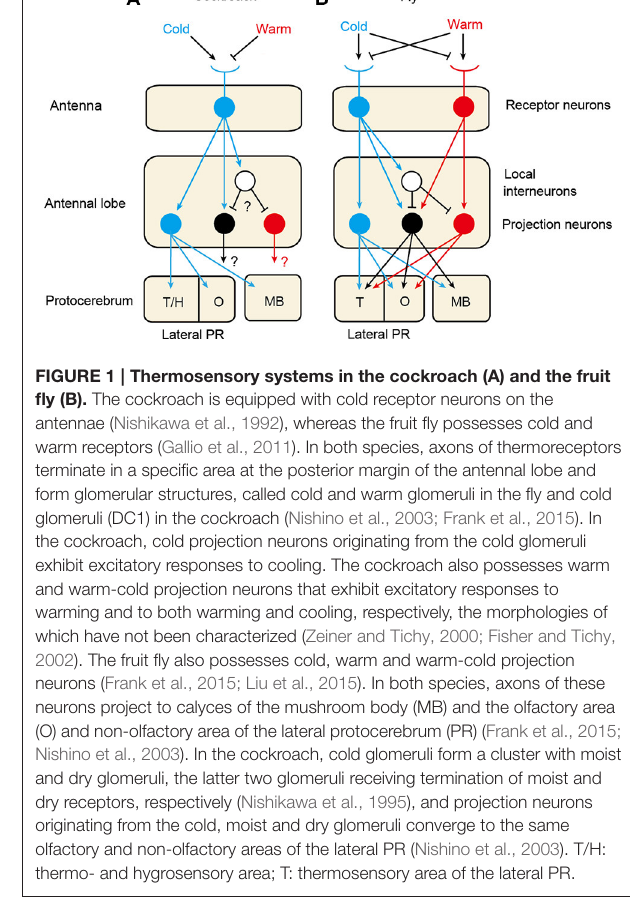
for survival of small animals such as insects (Yokohari,